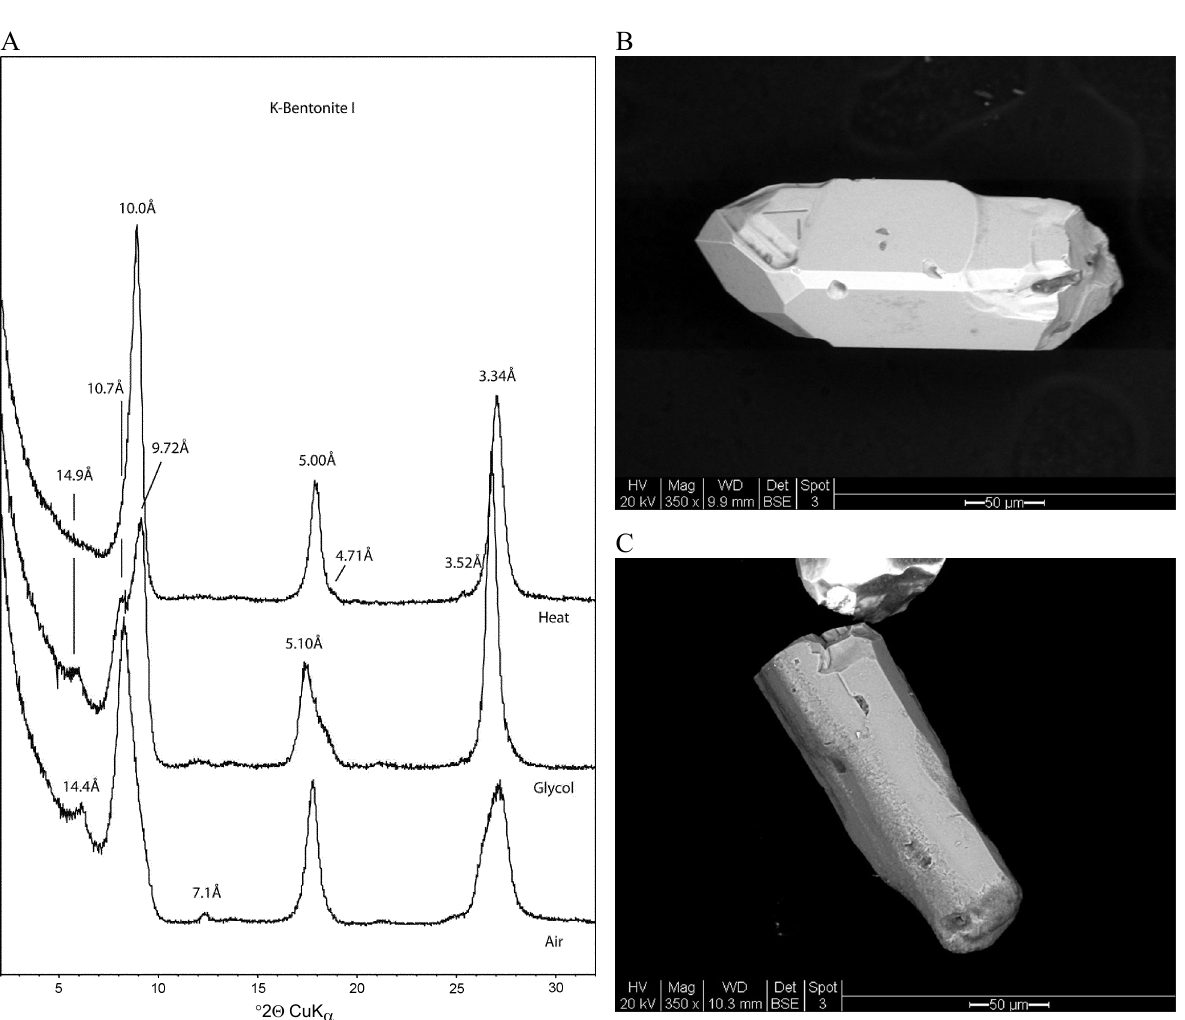
Fig. 2. A , X-ray diffraction patterns of K-bentonite bed 1 showing air-dried, glycolated and heated traces. B , C , ESEM images of apatite and zircon phenocrysts from bed